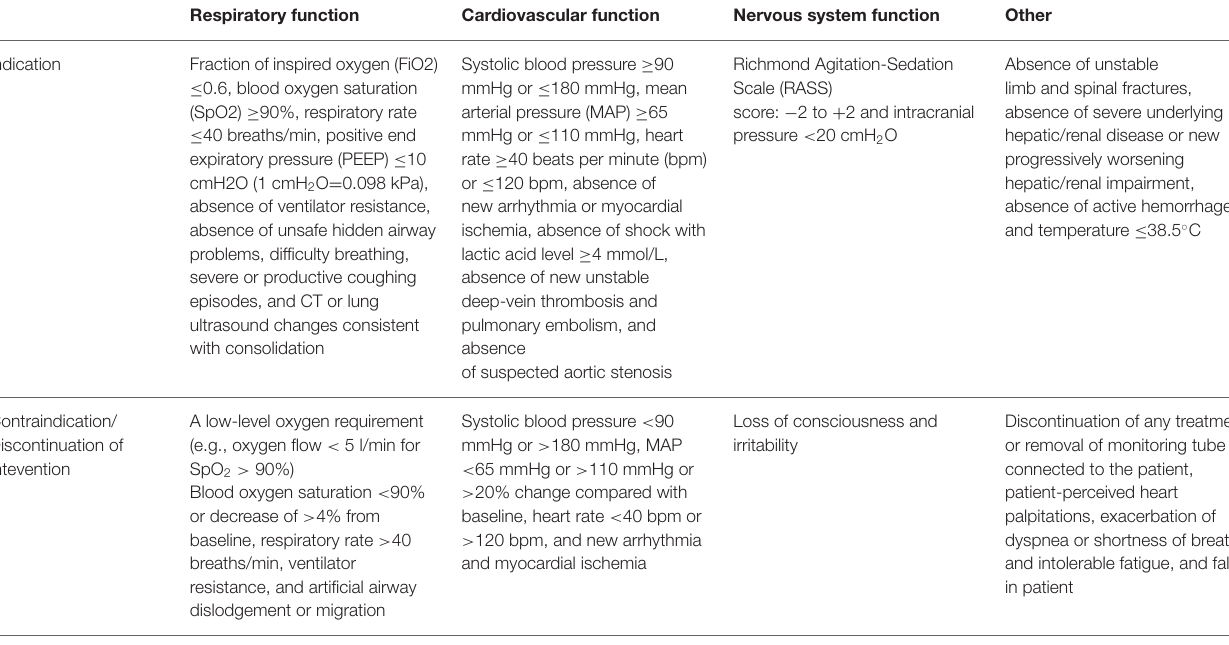
TABLE 2 | Indications and contraindications of chest physiotherapy in patients in mechanical ventilations [adopted from (15, 17, 20)]. Respiratory function Cardiovascular function Nervous system function Other